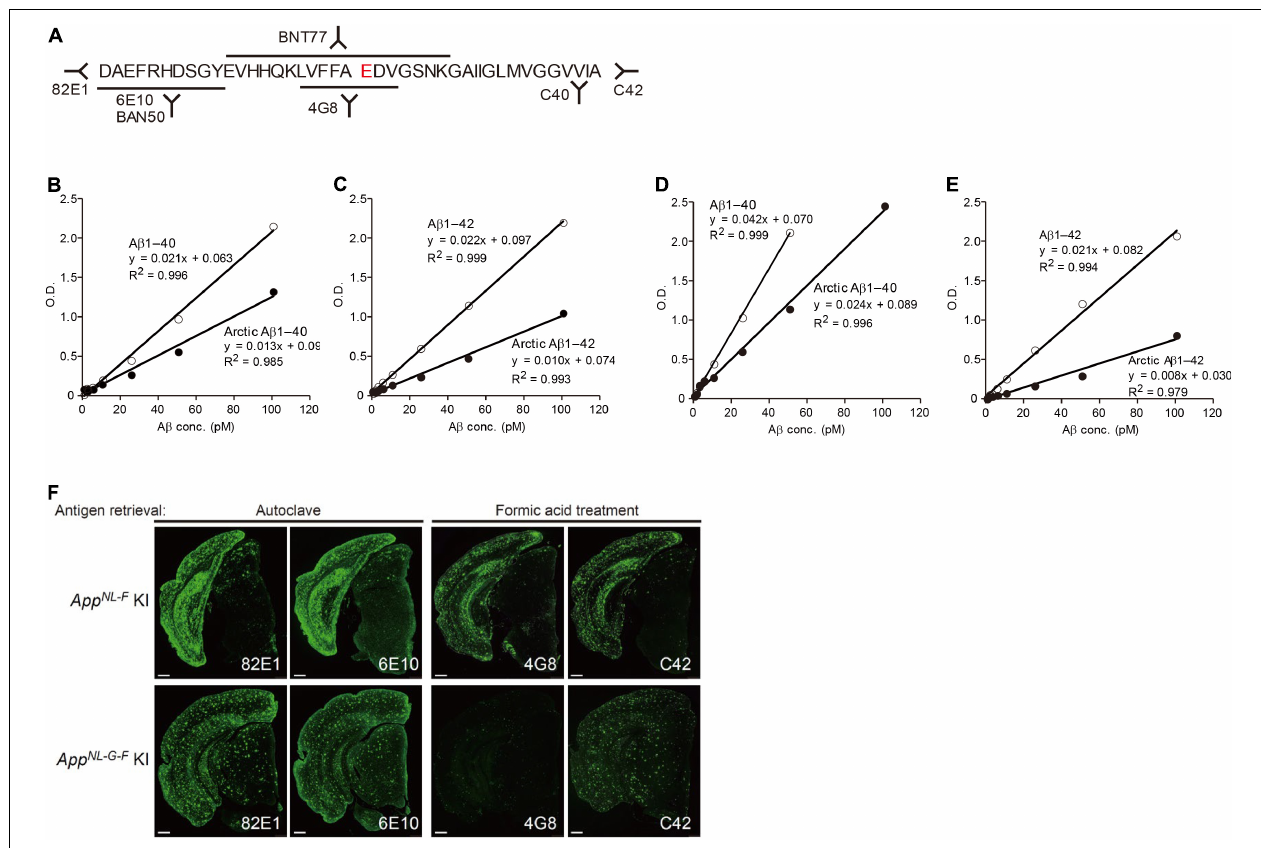
FIGURE 7 | Reactivity of different antibodies to Arctic A β in App NL − G − F mice. (A) Epitope map of anti-A β antibodies. (B,C) Quantification of Arctic A β species using BNT77 as a capture antibody. BNT77 binds to the mid-portion of A β [see epitope map (A) ]. A sandwich ELISA kit (Wako, Japan) was used to quantify A β x-40 (C) and A β x-42 (D) , respectively. (D,E) Quantification of Arctic A β species using BAN50 as a capture antibody. BAN50 binds to the N-terminal region of A β [see epitope map (A) ]. A sandwich ELISA kit (Wako, Japan) was used to quantify A β x-40 (D) and A β x-42 (E) , respectively. BNT77 and BAN50 captured Arctic A β more weakly than wild-type A β . (F) Immunohistochemistry using various anti-A β antibodies. Brain sections derived from App NL − F mice (24 months old) were immunostained using antibodies with different epitopes after antigen retrieval as indicated (upper panels); those of App NL − G − F mice (9 months old) were similarly immunostained (lower panels). Scale bars represent 500 µ